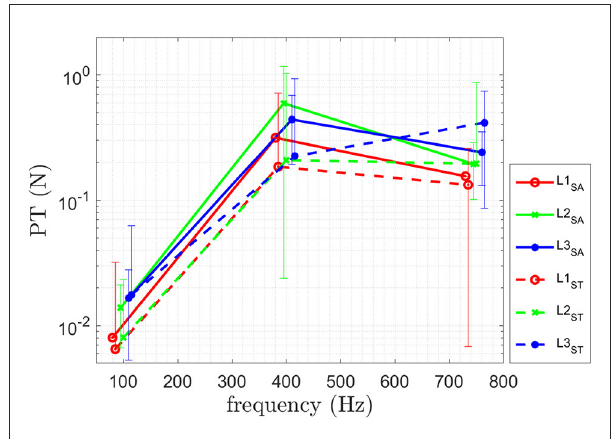
FIGURE3 Results of the psychophysical evaluation for PT of ten able-bodied subjects (SA) and for two trans-radial amputees (ST). Means and standard deviations of the identified PT at frequencies [100 400 750] Hz are shown.